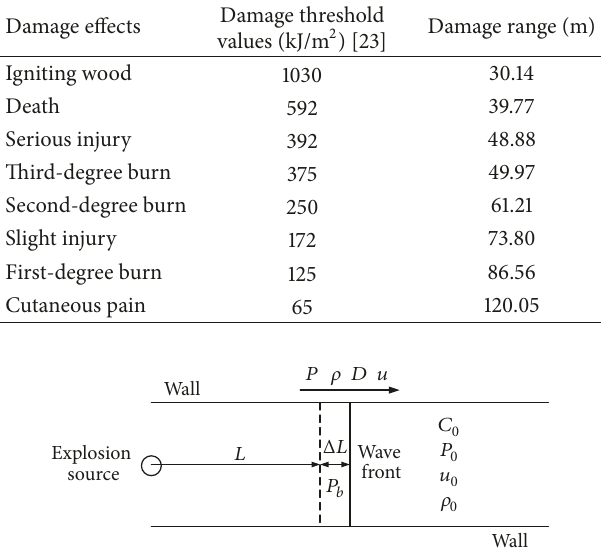
Table 1: Thermal radiation damage range for the thermobaric explosion in a tunnel.